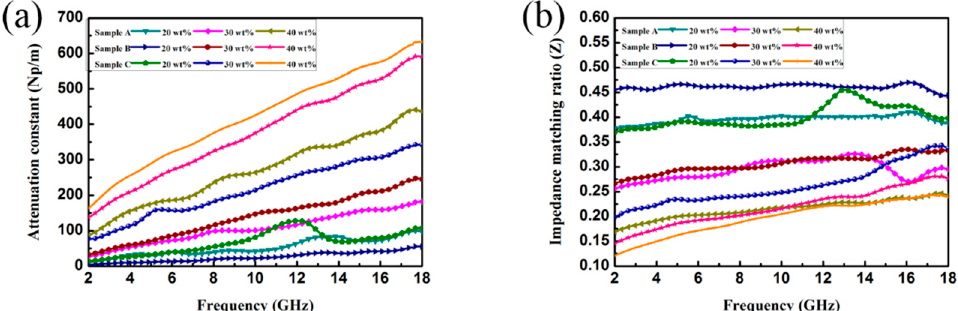
Figure 11. ( a ) Attenuation constant and ( b ) impedance matching ratio for the as-prepared samples containing different loading ratio.